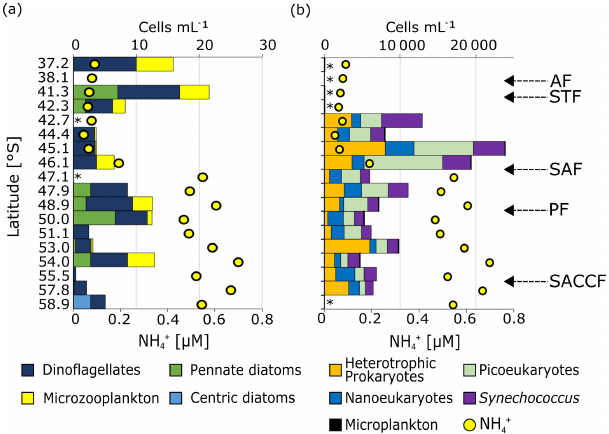
Figure 6. Surface community composition for (a) plankton ≥ 15µm (enumerated by microscopy) and (b) the total community < 15µm (enumerated by flow cytometry). For context, the surface NH + centration at each station is shown by the yellow circles. ∗ indicates stations at which no measurements were made while the absence of a bar with no ∗ indicates that no cells were detected. Note that the abundances shown in (b) (top x axis) are > 2 orders of magni- tude greater than those shown in (a) . The “microplankton” shown in (a) are included on (b) (slim black bars) to illustrate the differ- ence in abundance between the micro- and pico + nano populations. The frontal positions are indicated on (b) , with abbreviations as in Fig.